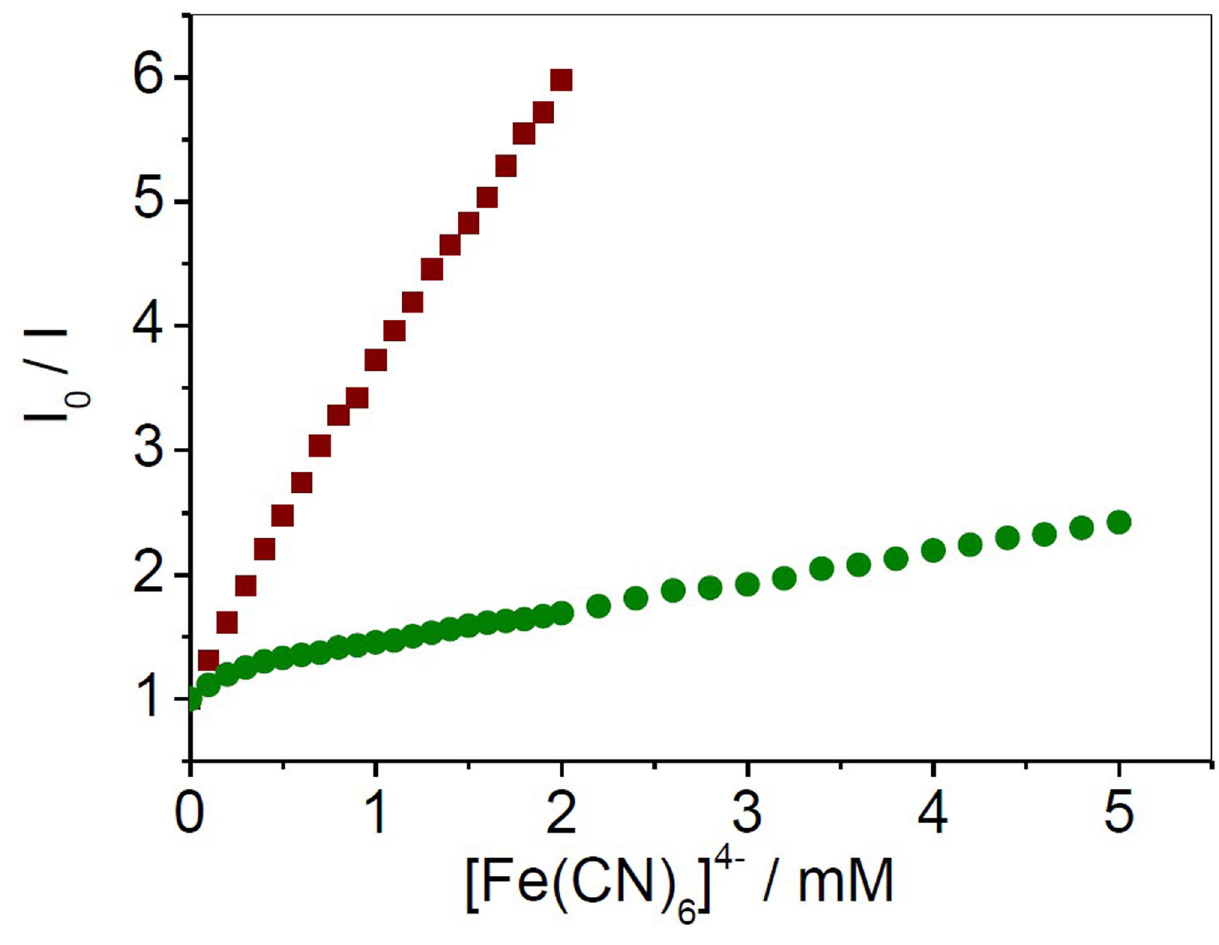
Figure 5. Binding modes assessed by Emission quenching